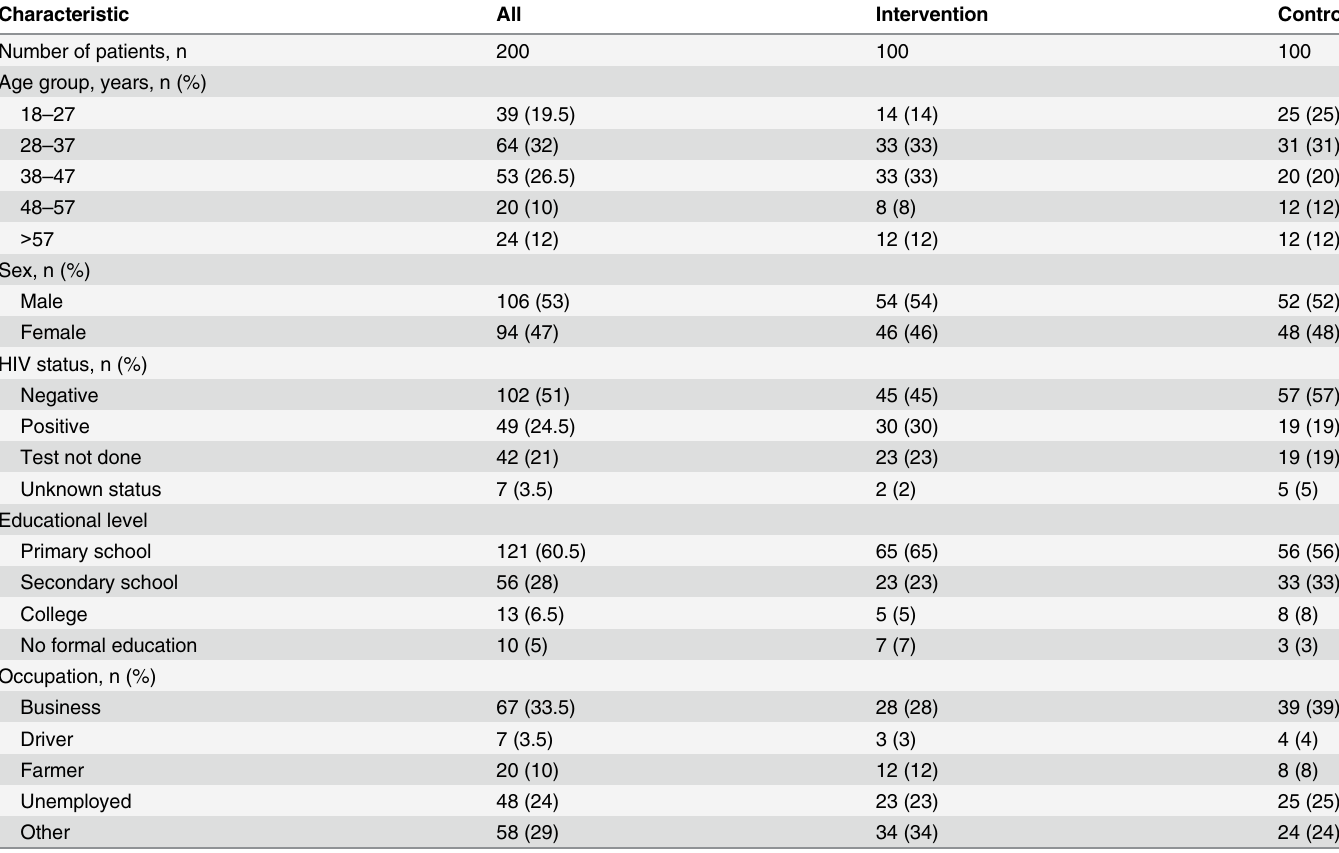
Table 1. Patient characteristics of study participants by intervention and control